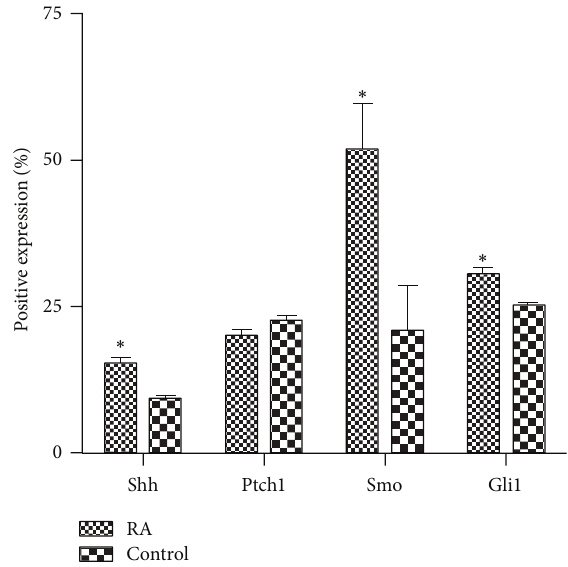
Figure 3: Positive expression rates of Shh-related proteins in synovium from RA patients and controls. The positive expression rate of Shh, Smo, and Gli1 protein in synovium of RA patients was higher than that in the control group, while there was no difference in the expression of Ptch1. ∗ 𝑃 < 0.05 versus control. The positive expression rate is defined as (number of positive cells/total cells) ×